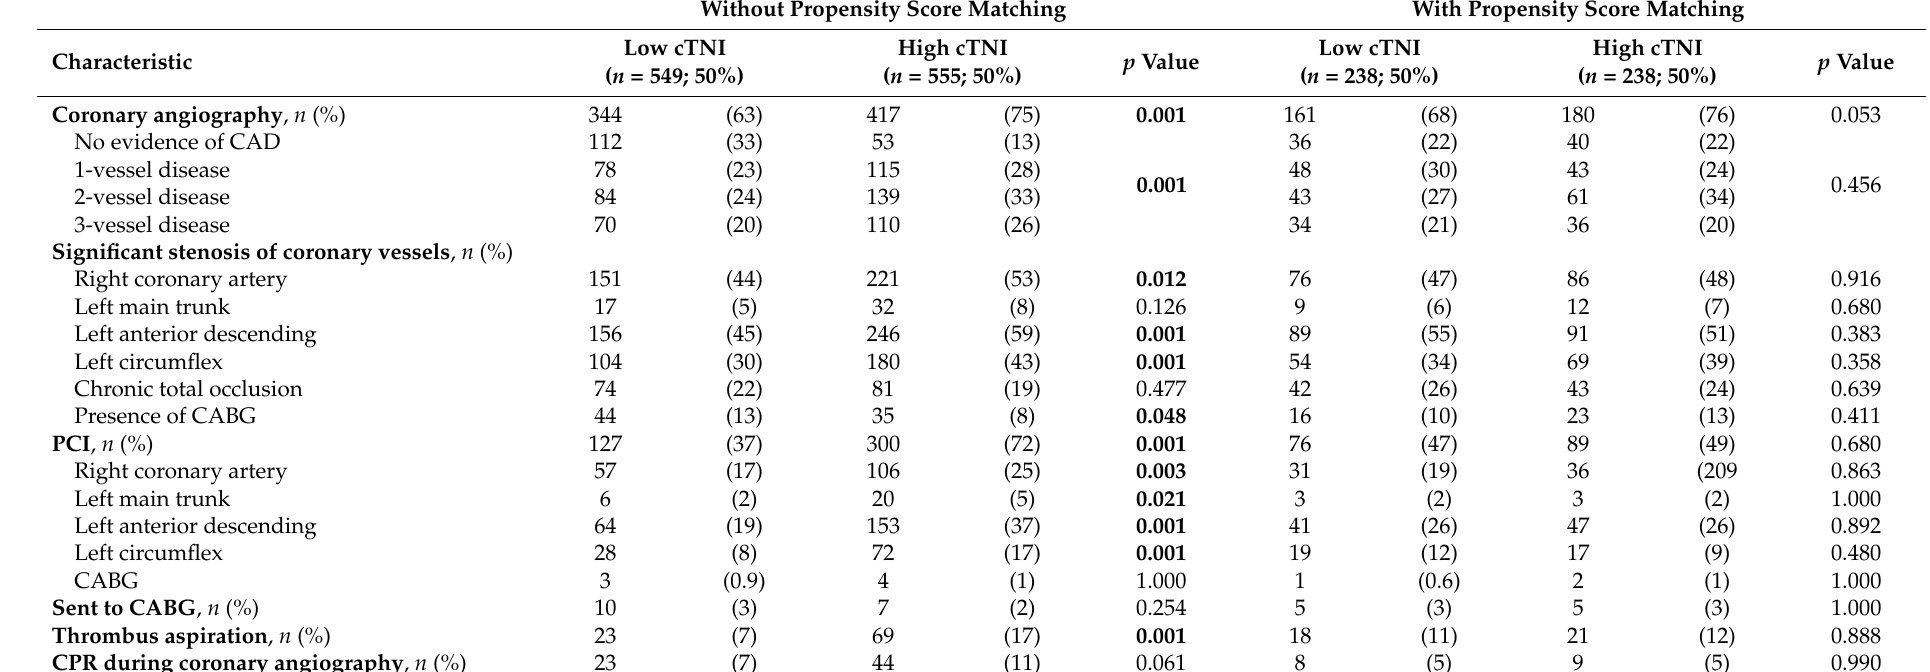
Table 2. CAD-related